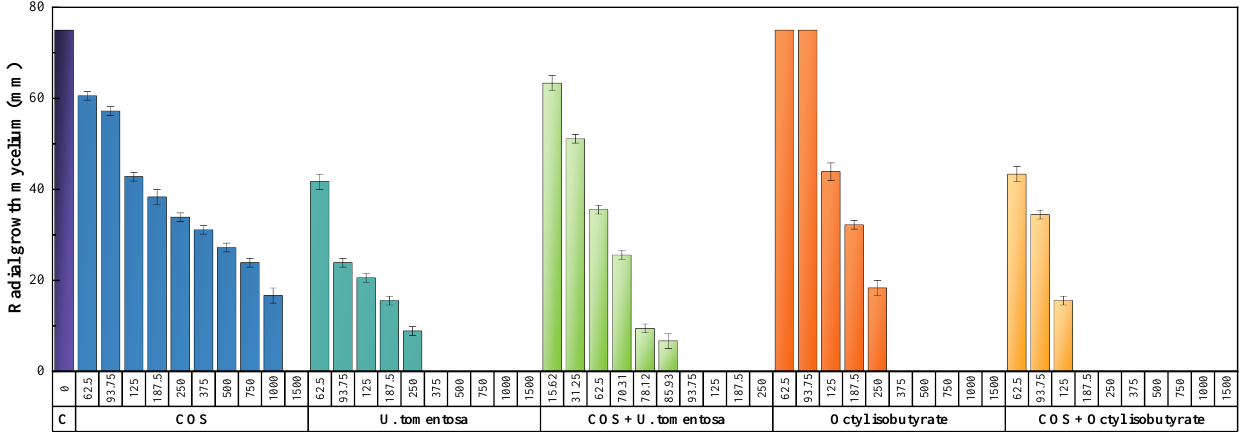
Figure 3. Inhibition of radial growth of the mycelium of B. cinerea in in vitro assays performed with different concentrations (in the 15.62 – 1500 µg·mL −1 range) of chitosan oligomers (COS), extract of U. tomentosa bark, the main constituent of the bark extract, and their respective conjugated complexes. Error bars represent standard deviations.